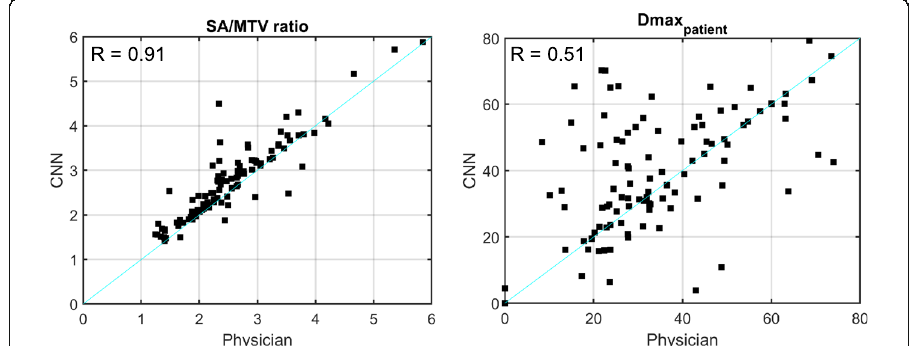
Fig. 5 Comparison of SA/MTV (left) and dissemination of lesions (right) on baseline imaging between automated and physician-based contours. Pearson ’ s correlation coefficients are shown in top left of each plot